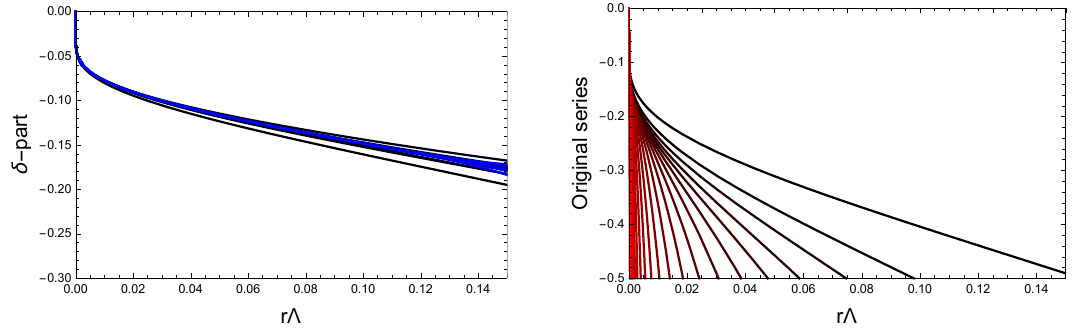
Figure 4 . Perturbative series of the (cid:14) part for the dimensionless potential rV QCD ( r ) (left). This is compared to the original series containing renormalons (right). Deeper blue (red) line corresponds to higher order result. The highest order is O ( (cid:11) 21 s